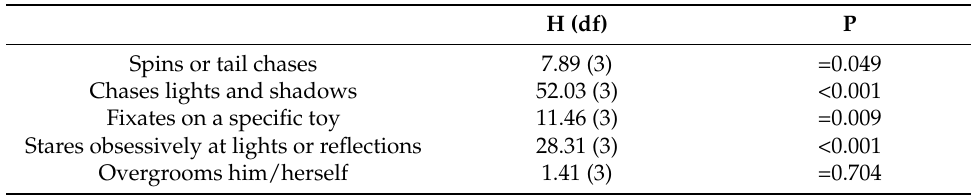
Table 4. Kruskal–Wallis test results assessing the association between laser light play and exaggerated or abnormal repetitive behaviors ( n =